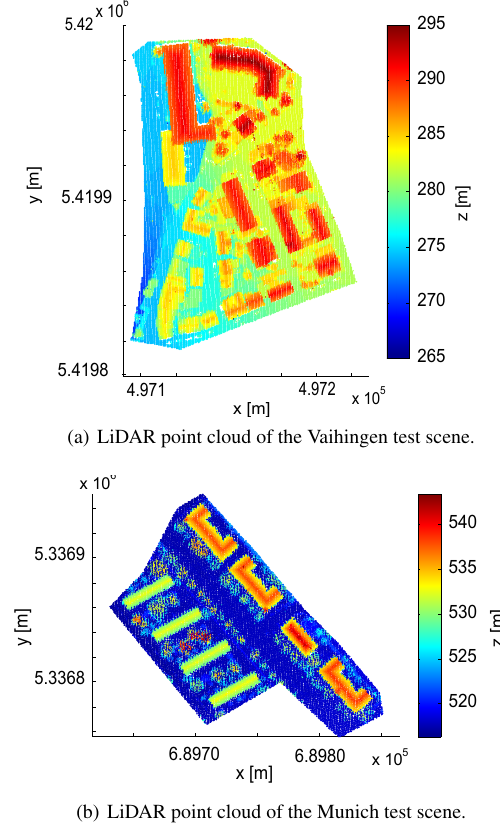
Figure 6. LiDAR point clouds of the test scenes.